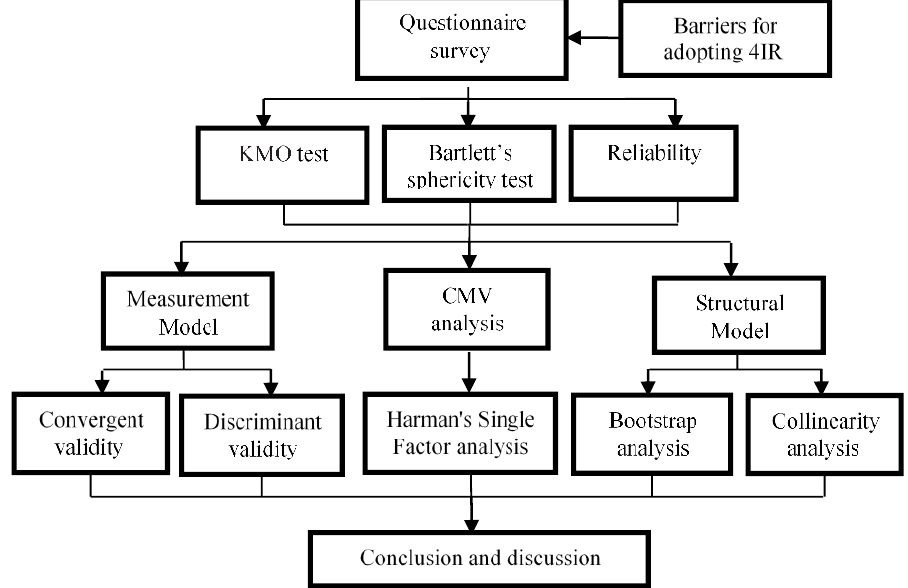
Figure 1. Research design.